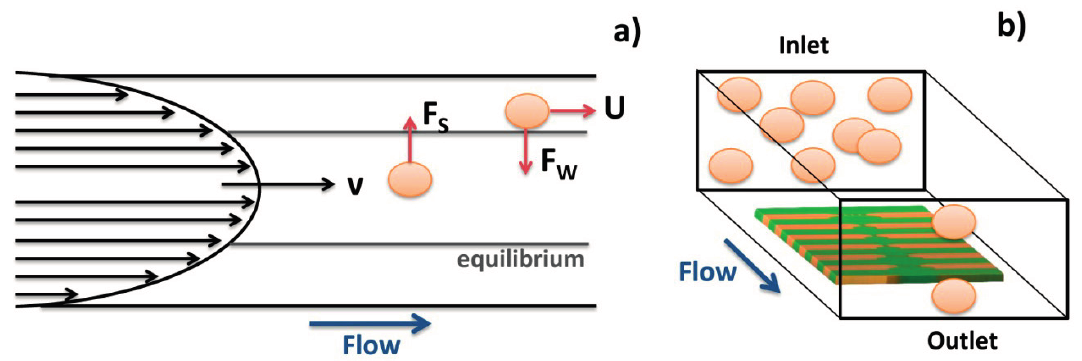
Figure 23. Schematics of inertial focusing in square microchannels. ( a ) Two lift forces in action, wall-induced F and shear-induced F lift forces; ( b ) In square channels randomly W S distributed particles or cells focus into four equilibrium positions at the wall